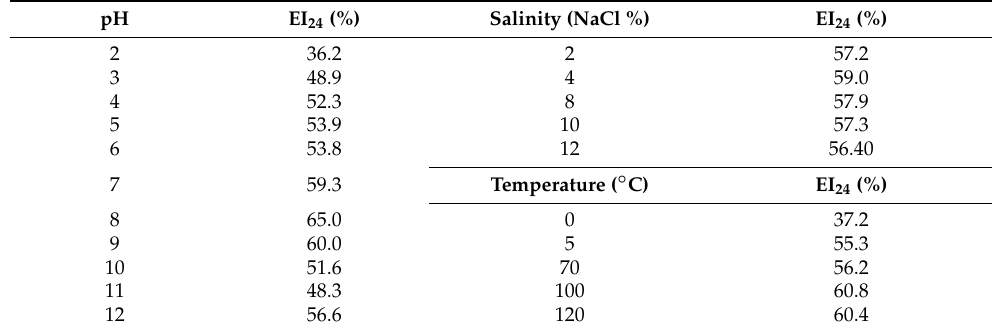
Table 7. Stability of the emulsifying activity of CL 84 under different pH, salinity and temperature conditions.